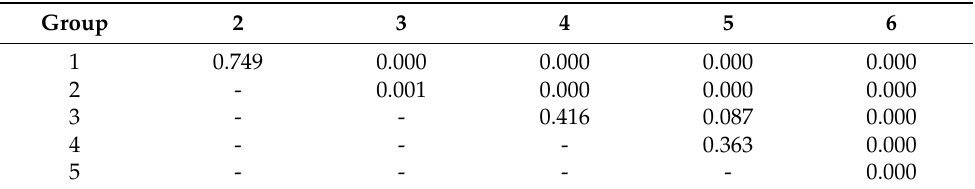
Figure 9. Influence of light-off delay on the average distance between the scanned data and prede- signed preparation data. 4. Discussion The convergence degree and the amount of prepared tooth are two important indi- cators of tooth preparation. This study explored a new method to improve the precise control of the convergence degree and the amount of prepared tooth and further enhance the accuracy of automated tooth preparation using a femtosecond laser. The automated